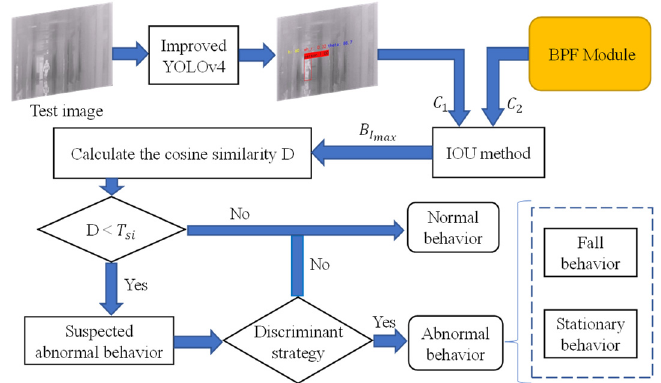
Figure 8. Abnormal behavior identification flowchart.